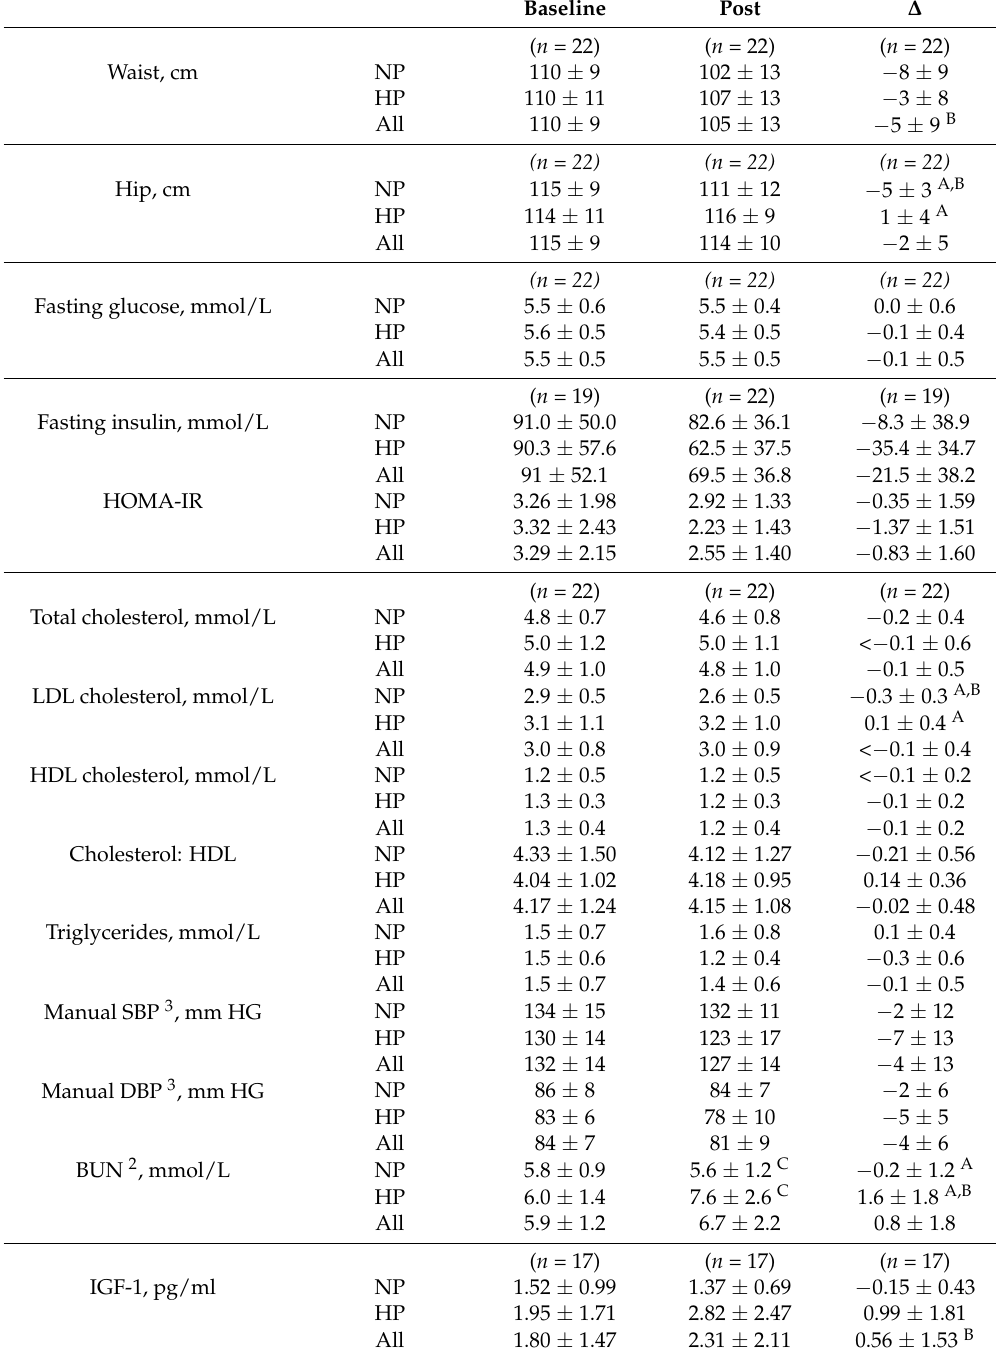
Table 5. Indices of cardiometabolic health 1